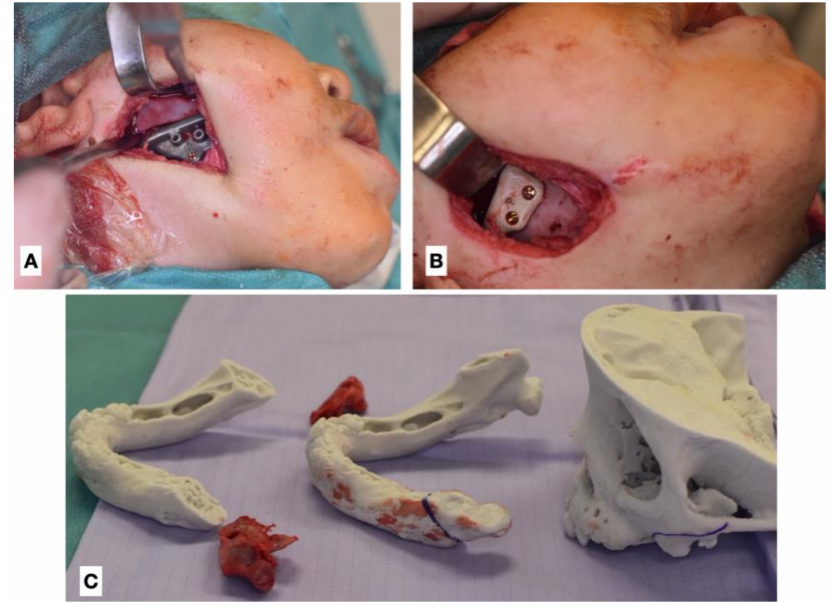
Figure 4. Intraoperative photographs of RAS performed in the 2-year-old patient (second attempt). ( A ) Intraoperative view with resection template, ( B ) intraoperative view with interpositional material in place (polyether ether ketone—PEEK), ( C ) stereolithographic model with removed osseous blocks. The range of ankylotic block resection is marked on the